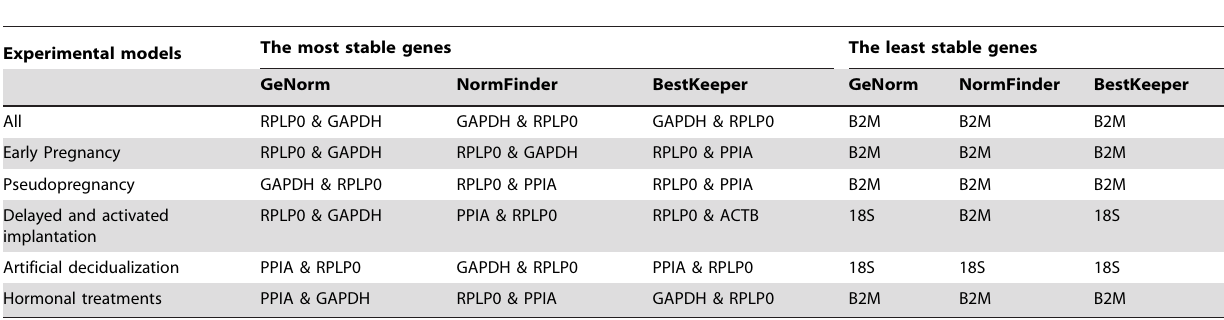
Table 5. Comparison of reference gene expression as determined by three distinct